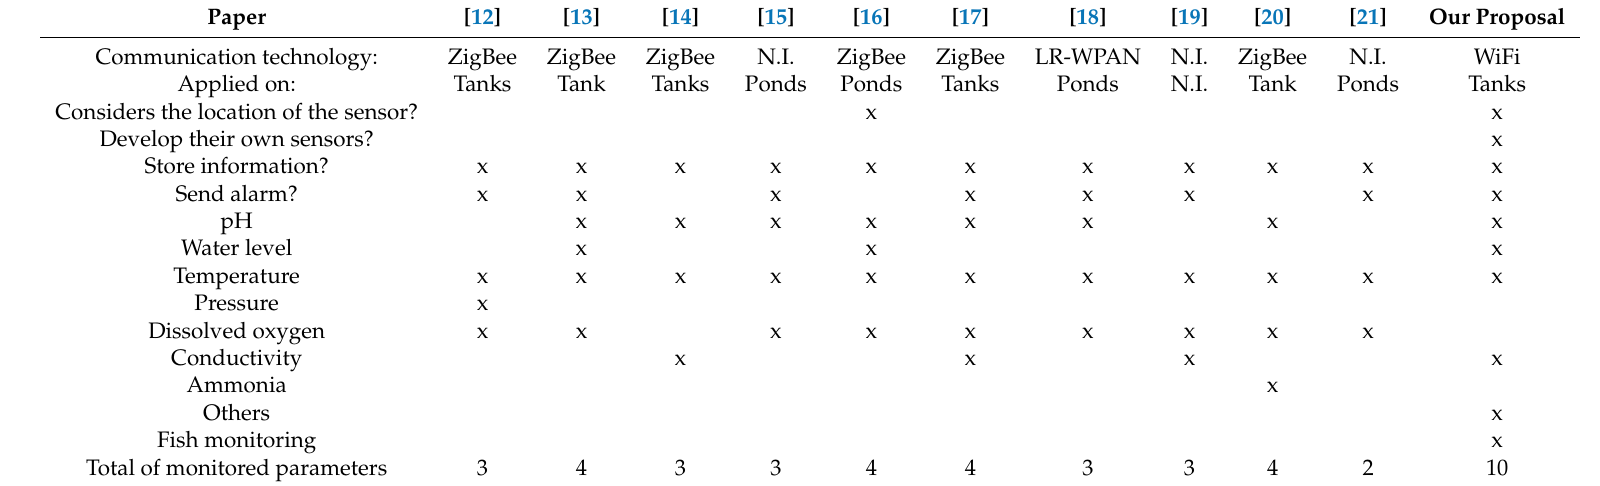
Table 1. Summary of characteristics of the current system and our